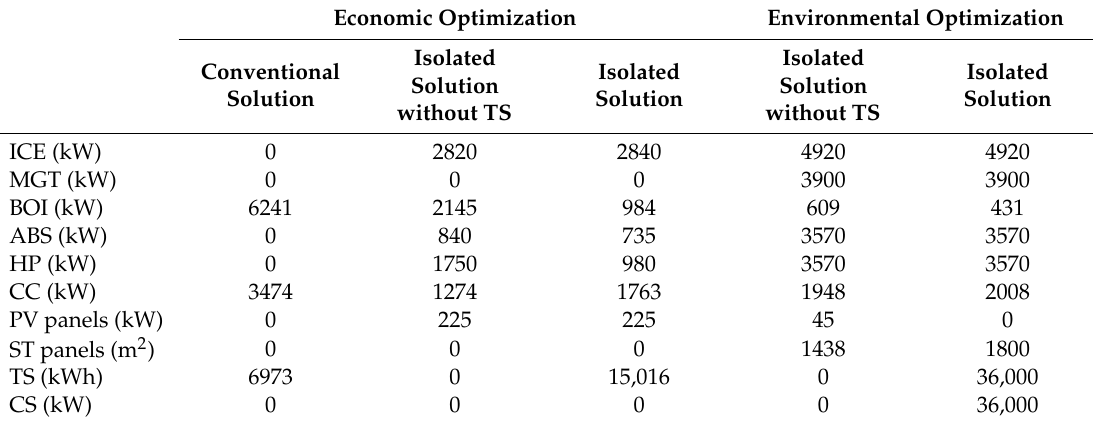
Table 6. Optimal configurations of the isolated solutions compared to the conventional